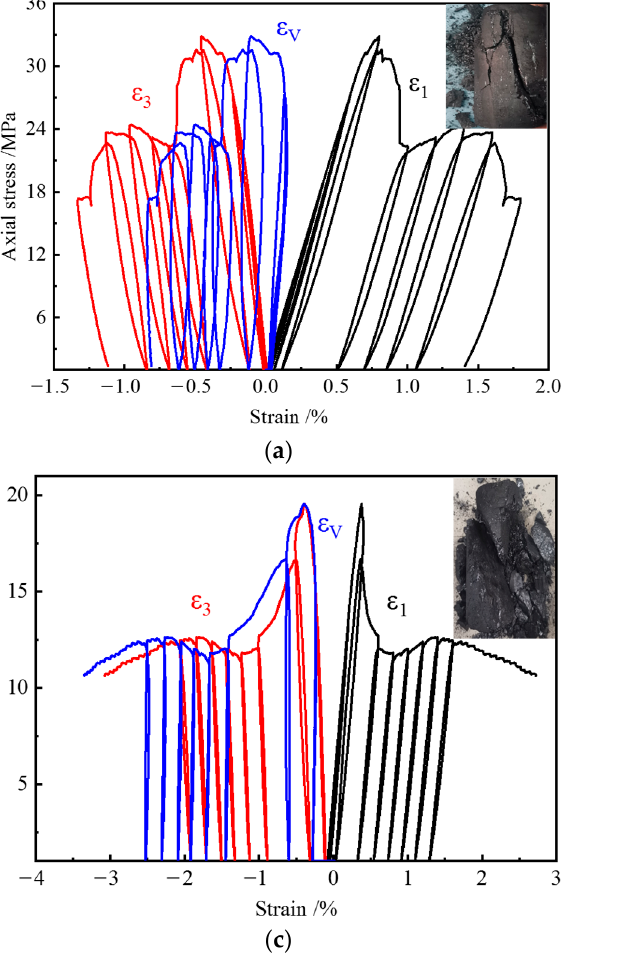
Figure 3. Stress–strain curves and failure of coal samples under uniaxial cyclic loading and unloading. ( a ) Gas pressure 0 MPa, ( b ) gas pressure 1 MPa, ( c ) gas pressure 2 MPa, and ( d ) gas pressure 3 MPa.